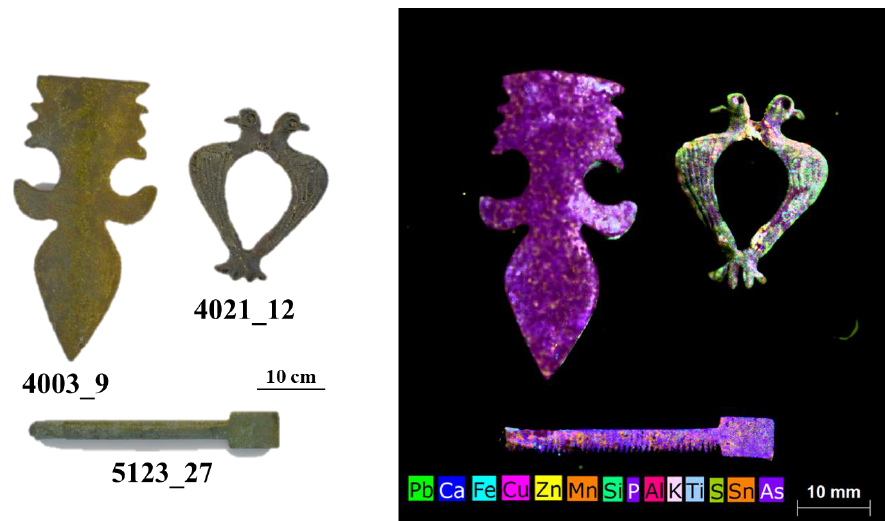
Figure 7. Photographs of the examined objects (i.e., applique, zoomorphic fibula, and spatula) and the XRF mapping of the detected elements.